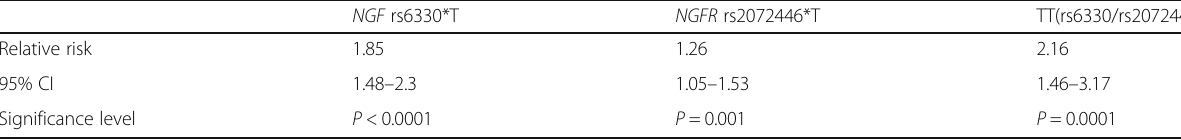
Table 5 Relative risk of IS among carriers of NGF rs6330*T, NGFR rs2072446*T and TT (rs6330/rs2072446)